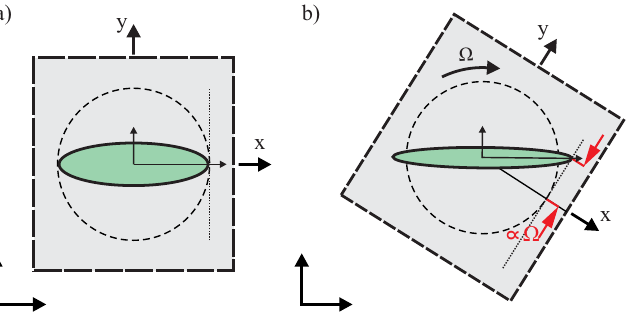
Figure 2. Theoretical response of a CVG to a rate of angular rotation Ω , in the gyroscope rotating frame: ( a ) no rotation, ( b ) applied a constant